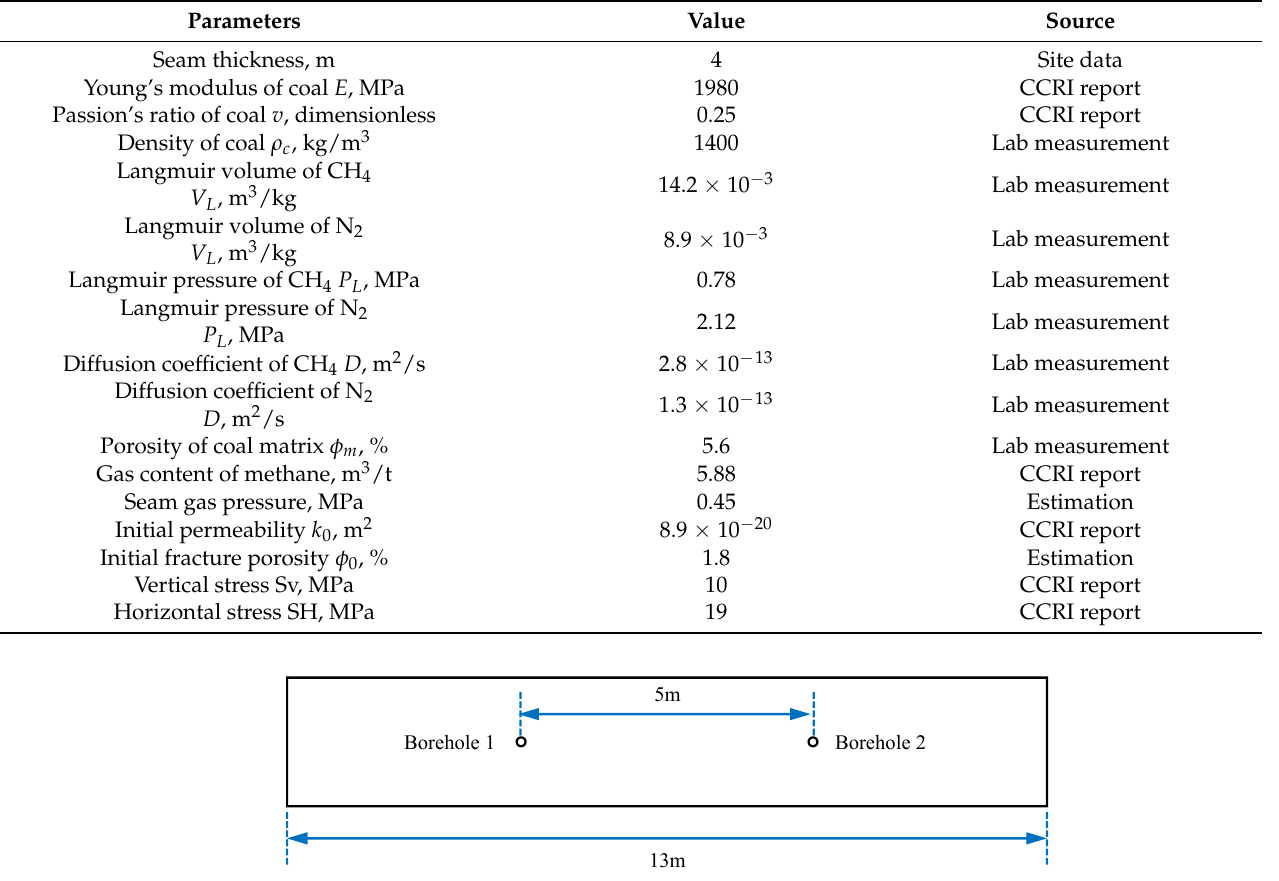
Table 1. Characteristic parameters of coal seam.